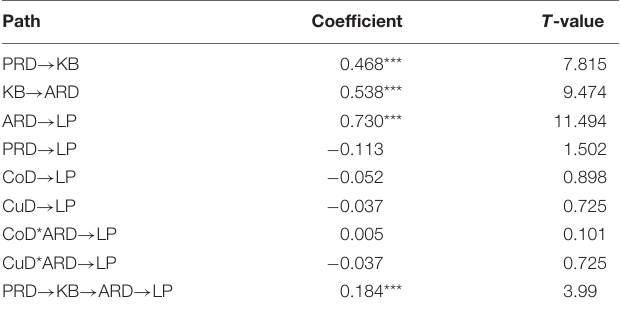
TABLE 3 | Test of moderating effect of cultural and cognitive differences in Learning Mechanism 3 ( N = 240). Path Coefficient T